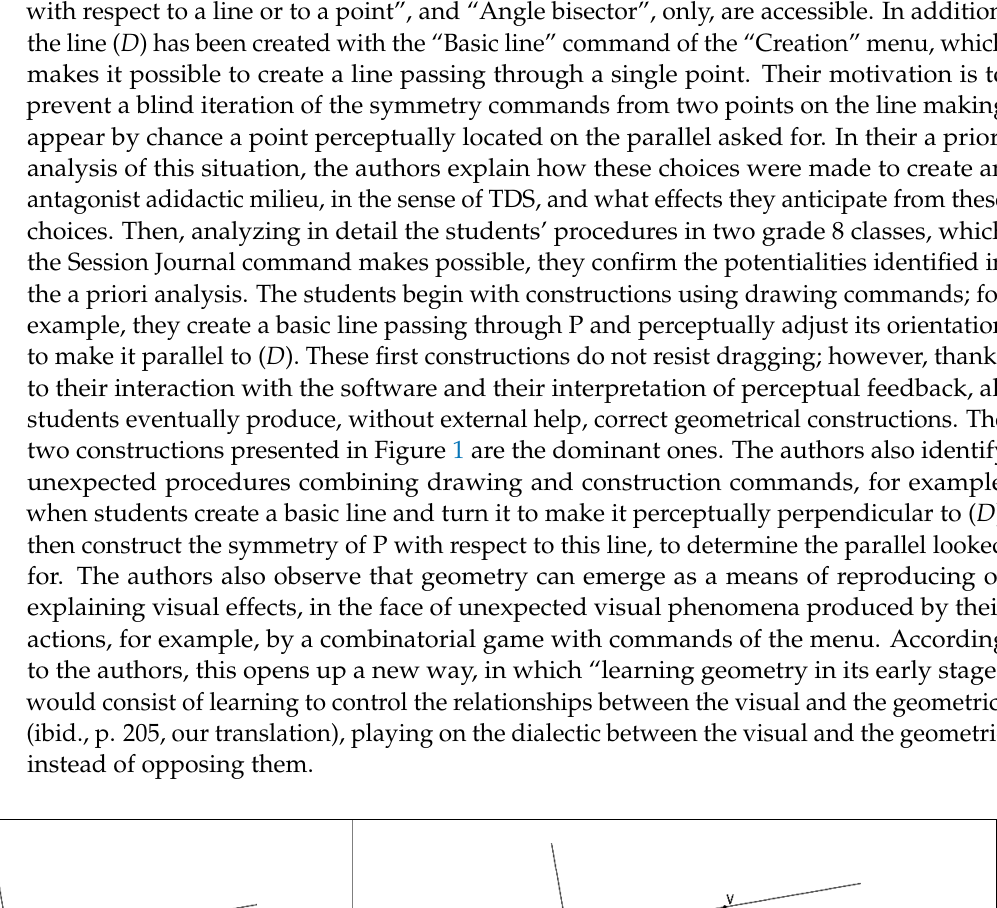
famous “black-box” situations, where students have to discover what is hidden behind a